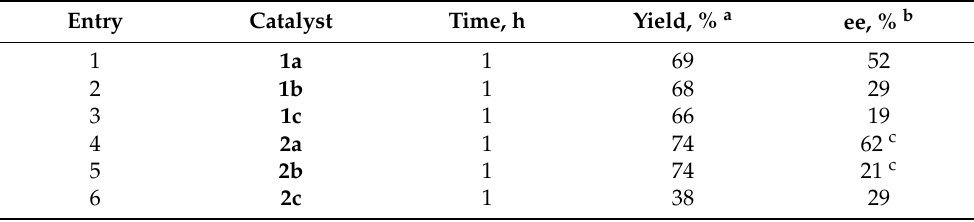
Table 1. Effect of the crown catalysts ( 1 or 2 ) in Darzens condensation of 2-chloroacetophenone ( 10 ) and benzaldehyde ( 11 ).